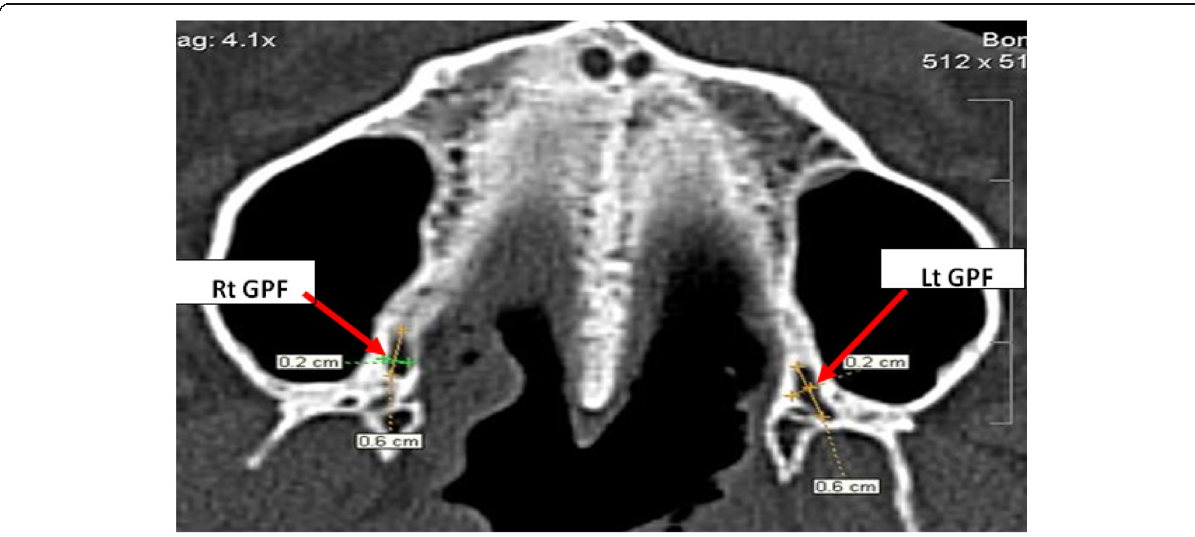
Fig. 6 A CT scan at the region of hard palate illustrating the dimensions of the greater palatine foramina (GPF)